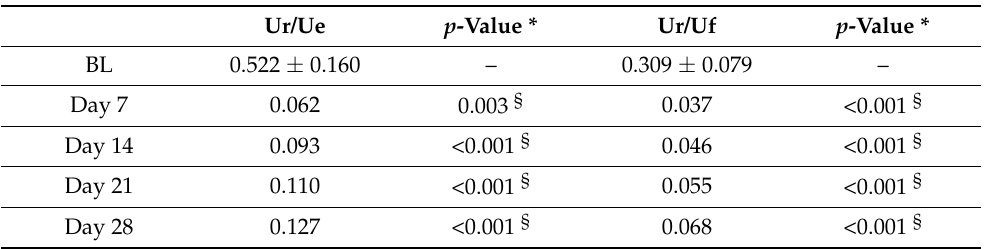
N = 41. The data were gathered by cutometry in area A1 (= treated with Emollient 3) and are presented as arithmetic means. BL = Baseline value (absolute mean ± SD) before first product application; Ur/Ue = net elasticity; Ur/Uf = ratio of elastic recovery to distensibility. * For mean change from baseline, paired t -test. § Significant if p < 0.0125 (Bonferroni correction). Note: An increase in Ur/Ue and Ur/Uf reflects